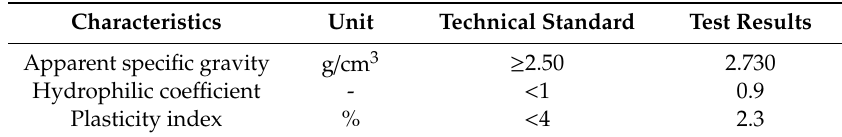
Table 4. Physical characteristics of mineral filler.